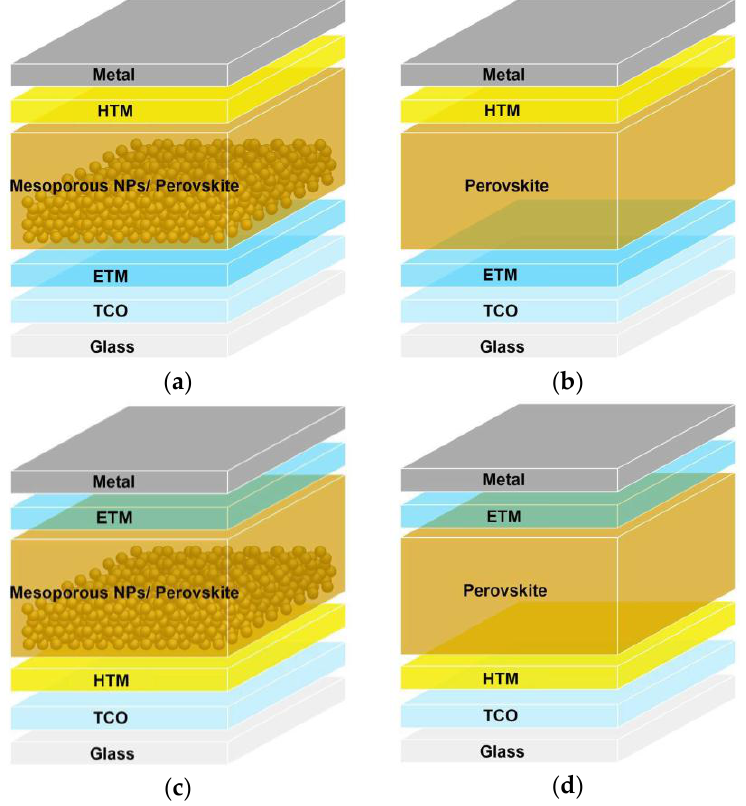
Figure 3. Schematic organometallic lead halide perovskite solar cell (PSC) architectures: ( a ) mesoporous n-i-p PSC; ( b ) planar n-i-p PSC; ( c ) mesoporous p-i-n PSC; and ( d ) planar p-i-n PSC.